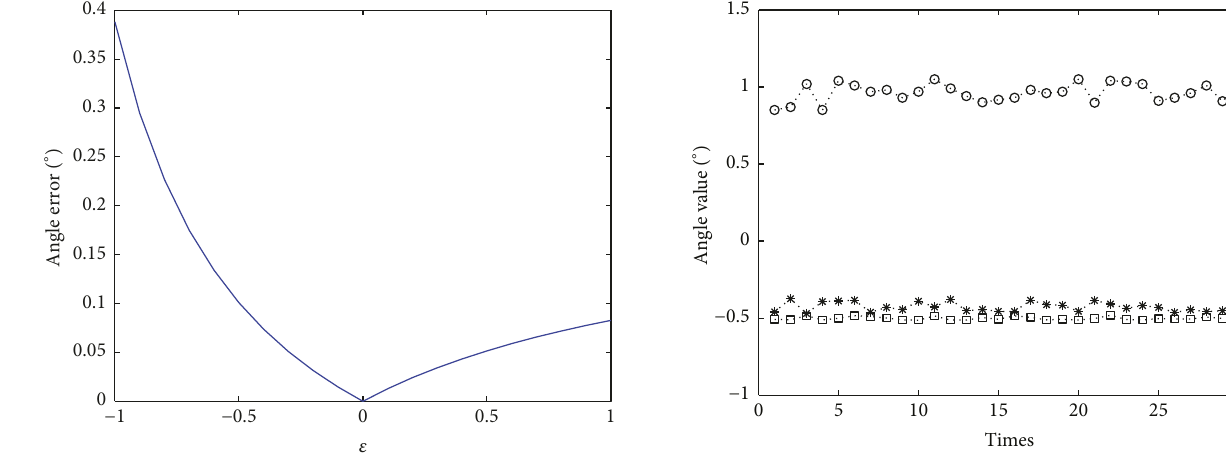
Figure 3: Angle estimation error caused by 𝜀 .